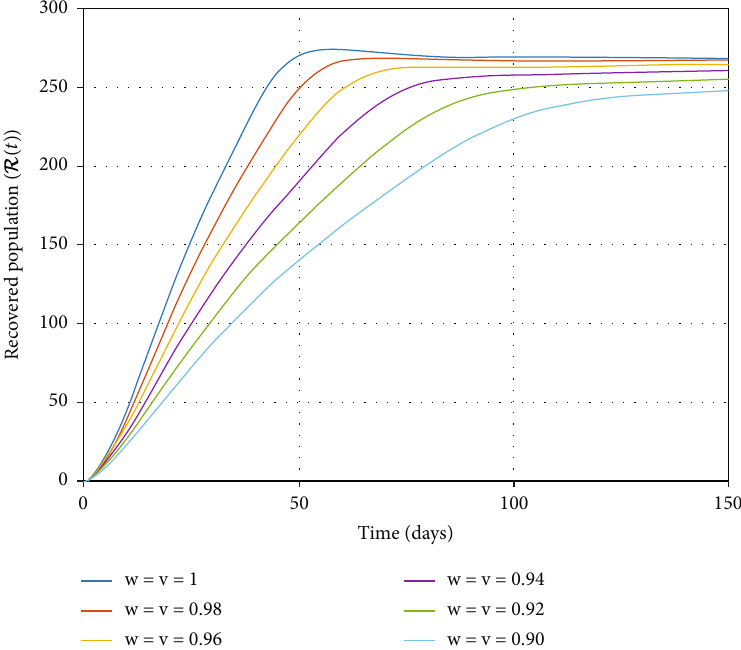
Figure 7: Behavior of R ð t Þ by changing fractal-fractional order ω and v